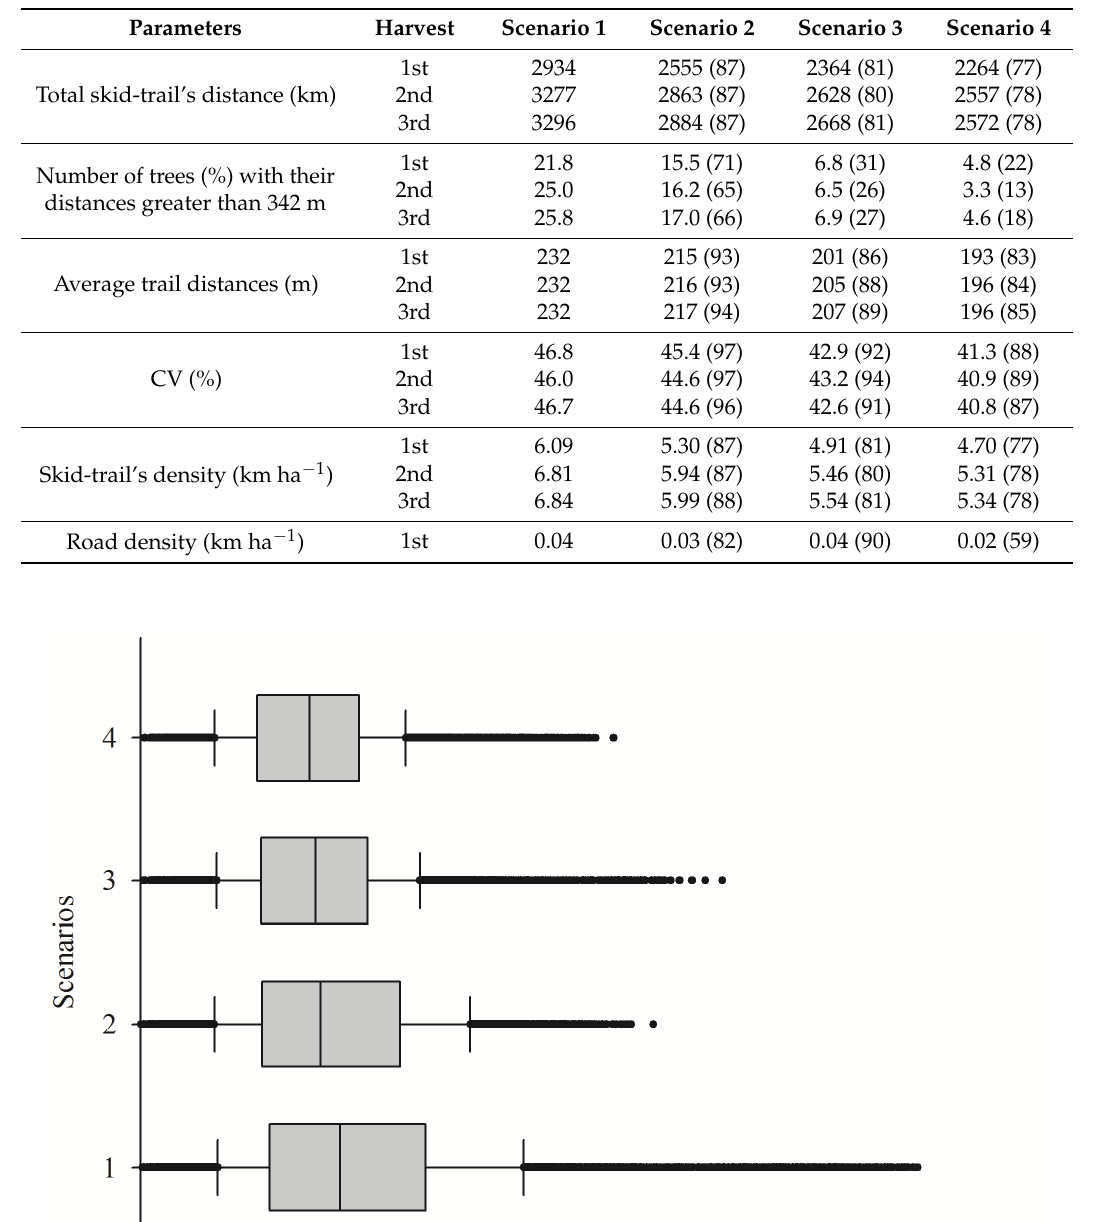
Table 3. Scenario evaluation based on skid-trails’ distances, and densities of trails and roads. Numbers between parentheses indicate the difference in percentage (%) from scenario 1.